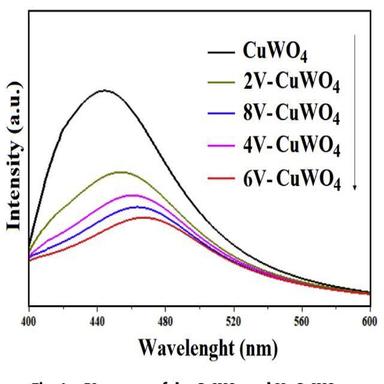
PL spectra of the CuWO4 and VeCuWO4.